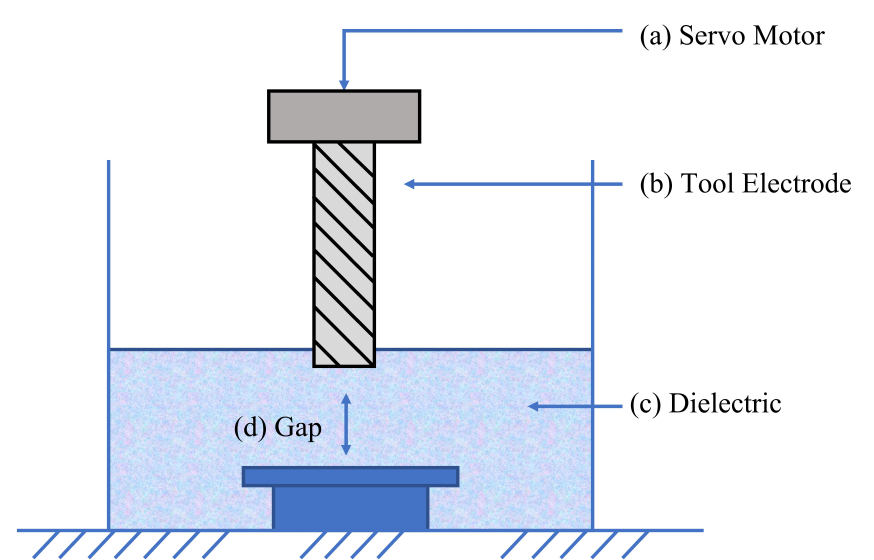
Figure 8. Schematic of an electric discharge machining (EDM) machine